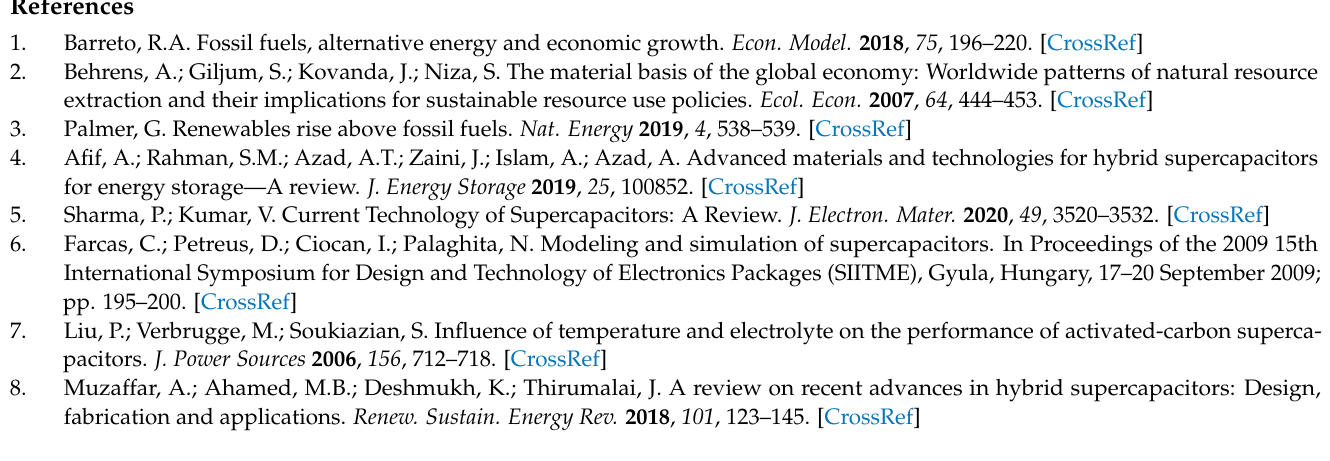
Figure S2: Plot of specific capacitance with relation to scan rate in KCl (left) and KNO3